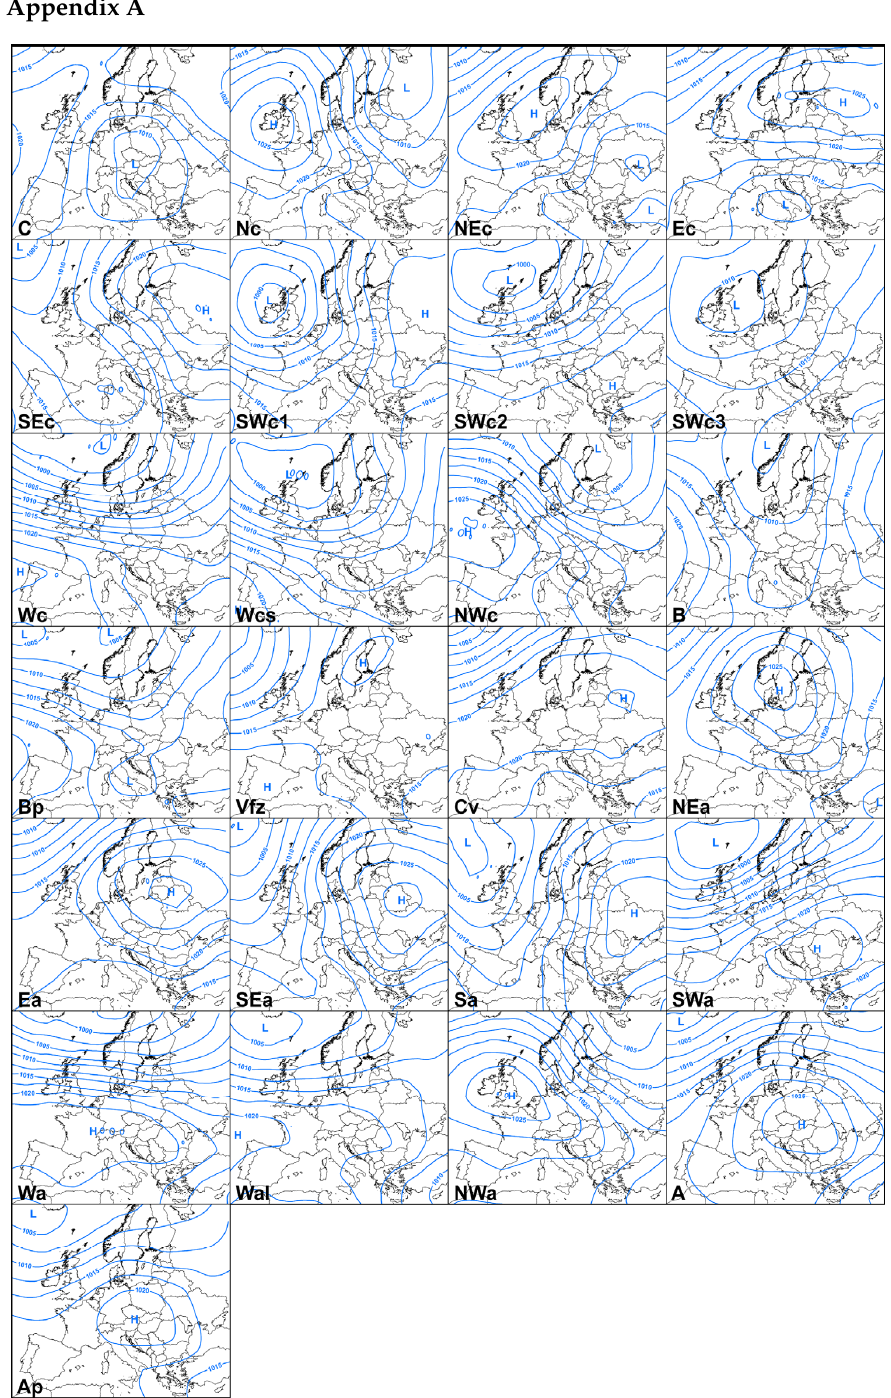
Figure A1. Mean SLP fields for the 25 circulation types under the CHMI classification [31,49] created for the 1961–2020 period. Types: C, cyclone over Central Europe; Nc, north cyclonic; NEc, northeast cyclonic; Ec, east cyclonic; SEc, southeast cyclonic; SWc1, southwest cyclonic of the 1st type; SWc2, southwest cyclonic of the 2nd type; SWc3, southwest cyclonic of the 3rd type; Wc, west cyclonic; Wcs, west cyclonic with southern pathway; NWc, northwest cyclonic; B, trough over Central Europe; Bp, travelling trough; Vfz, entry of the frontal zone; Cv, upper cyclone; NEa, northeast anticyclonic; Ea, east anticyclonic; SEa, southeast anticyclonic; Sa, south anticyclonic; SWa, southwest anticyclonic; Wa, west anticyclonic; Wal, west anticyclonic of summer type; NWa, northwest anticyclonic; A, anticyclone over Central Europe; Ap, travelling anticyclone.